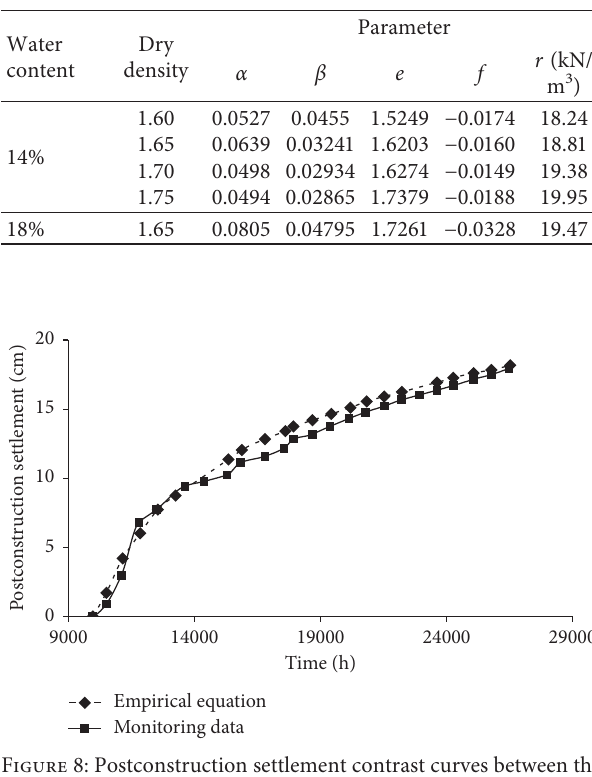
Table 3: Testing parameters.